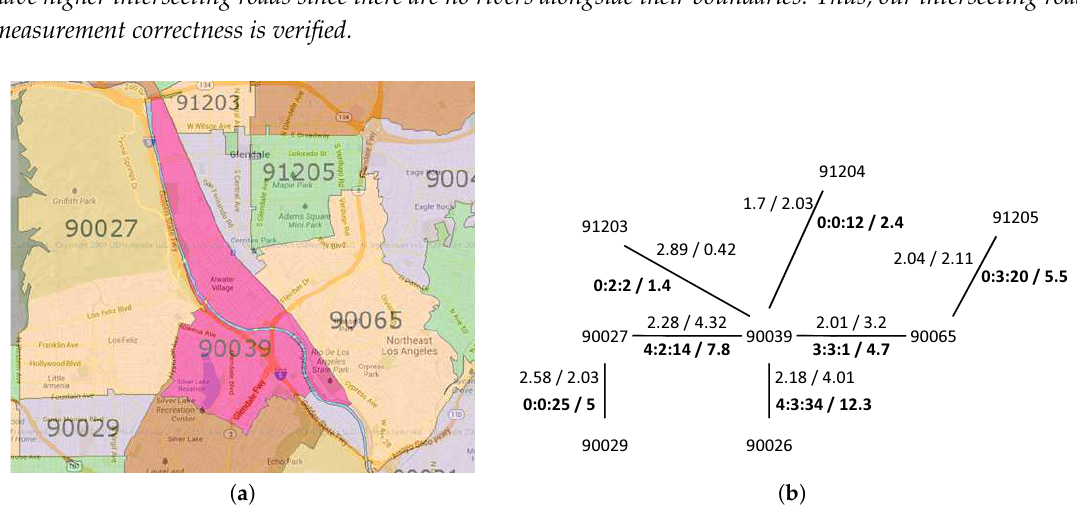
Figure 16. River-separated ZIP code graph. ( a ) map; ( b ) ZIP code